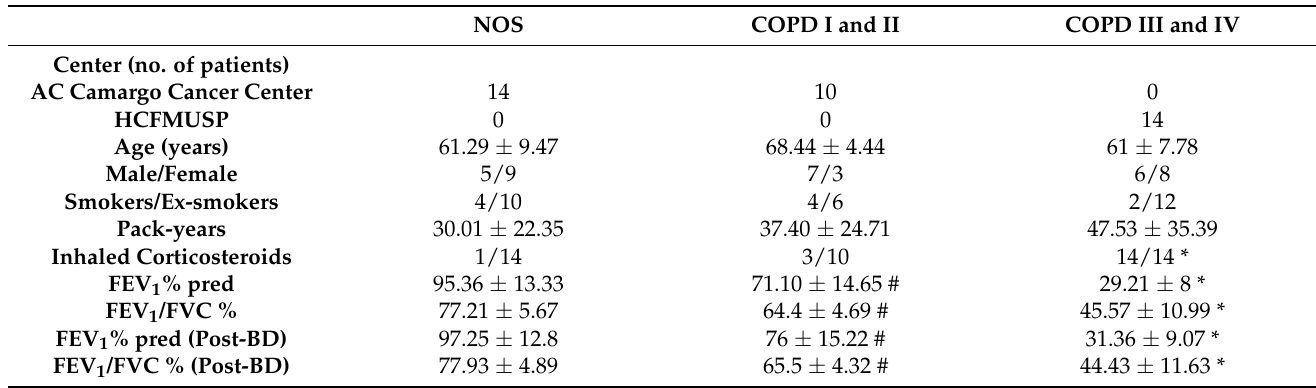
Table 2. Characteristics of the patients: gender, age, smoking habit, and pulmonary function values. NOS COPD I and II COPD III and IV Center (no. of patients)